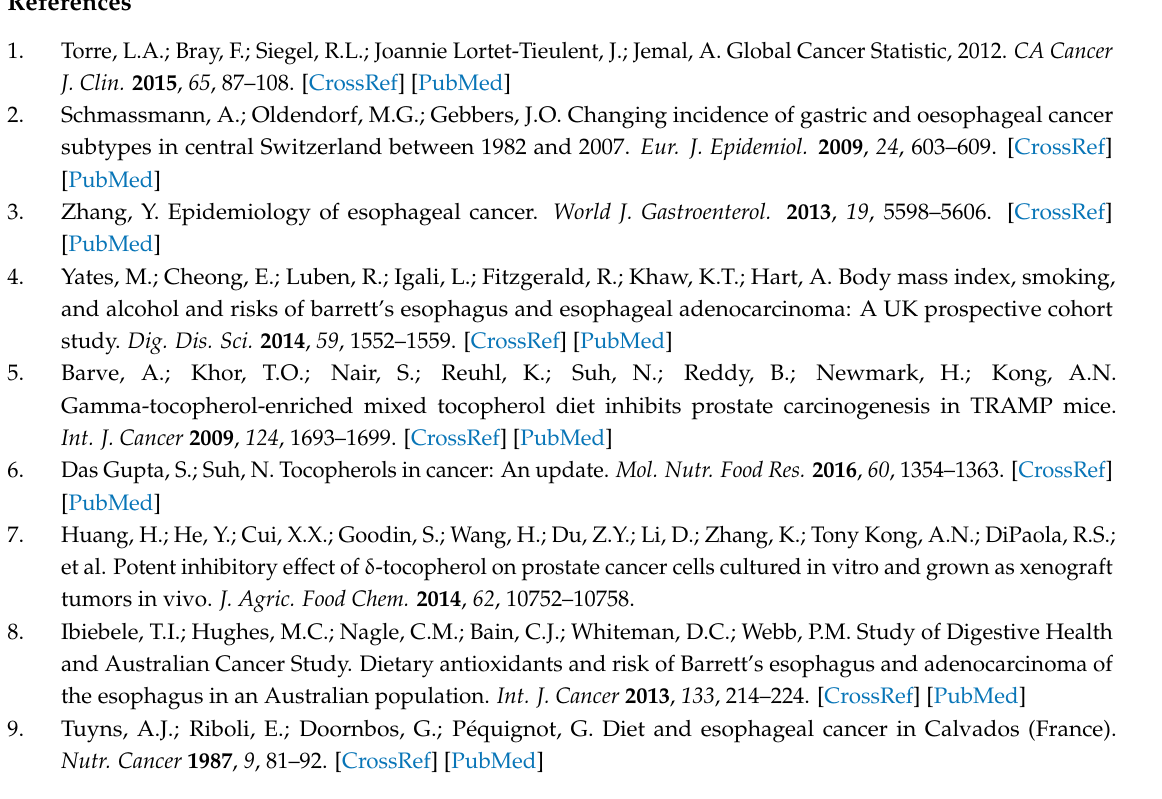
Figure S1: The sensitive analyses for studies on the association between dietary vitamin E intake and the esophageal cancer risk. Table S1: Methodological quality of case-control studies included in the meta-analysis, Table S2: Methodological quality of prospective studies included in the